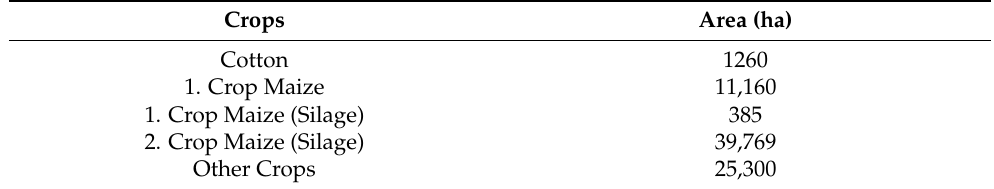
Figure 2. Land cover classification map of the middle part of the study area. Table 2. Area of cultivated crop pattern in the Küçük Menderes Basin.